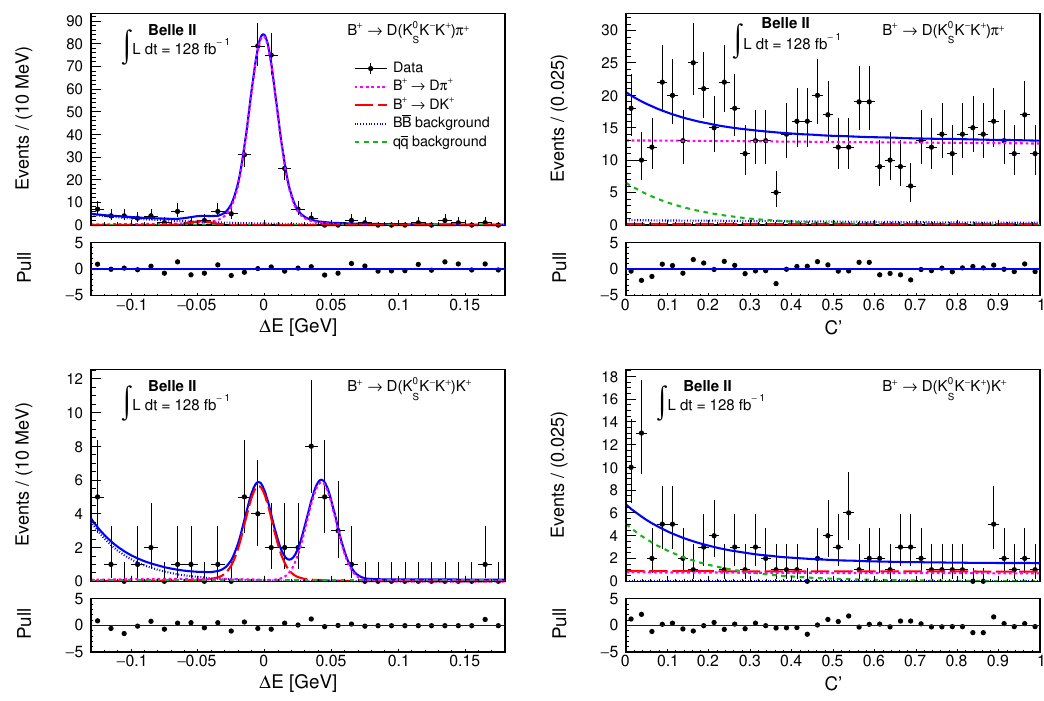
Figure 5 . Distributions of (left) ∆ E and (right) C 0 for (top) B + → D ( K 0 B + → D ( K 0 K − K + ) K + candidates restricted to the signal-enhanced region in the Belle II data set S with fit projections overlaid. The black points with error bars represent data and the solid blue curve is the total fit. The large-dotted magenta, long-dashed red, small-dotted blue and short-dashed green curves represent B + → Dπ + , B + → DK + , q ¯ q and combinatorial B ¯ B background components, respectively. Differences between the fit function and data normalised by the uncertainty in data (pull) are shown under each